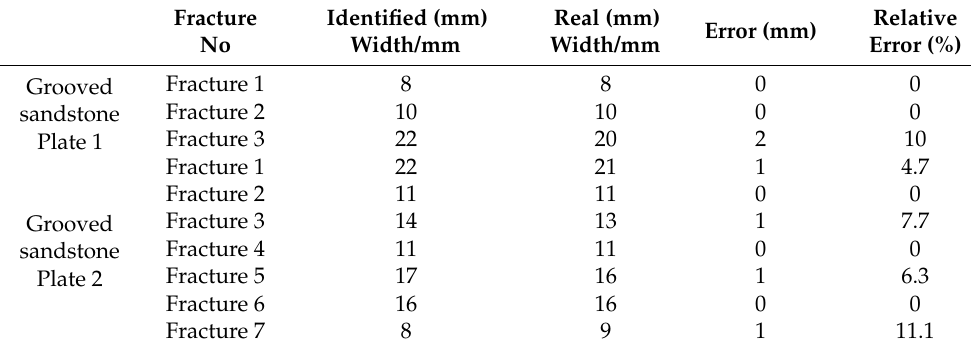
Figure 18. Echo amplitude imaging diagram for the grooved sandstone Plate 2. Table 1. Comparison of identified fracture width with real values.